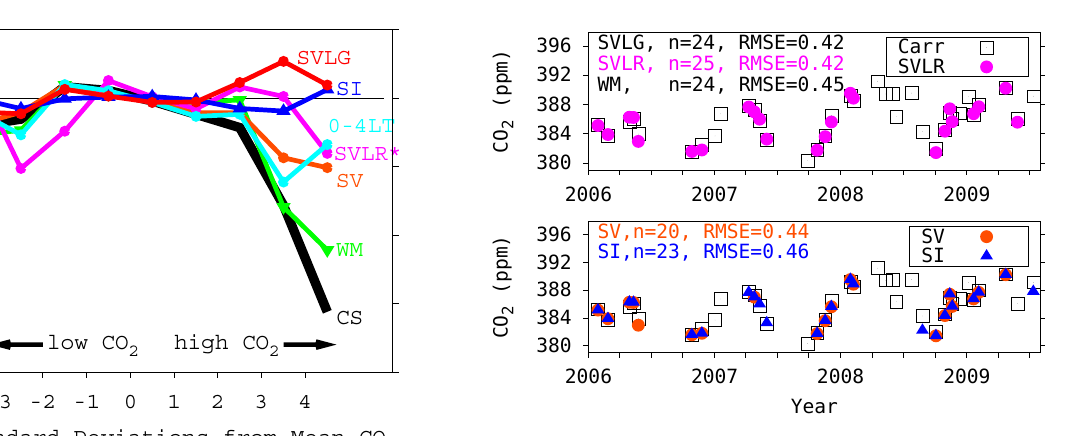
Fig. 4. CO 2 lapse rates binned by standard deviations from the deseasonalized subset mean. These show the average degree of CO 2 stratification in the vicinity of the measurement stations. On the vertical axis (CO 2 lapse rate) measurements representing well- mixed conditions appear near-zero, while measurements represent- ing strongly stable conditions have large negative values. On the horizontal axis (standard deviations) measurements typical of after- noon CO 2 uptake appear to the left, while nocturnal measurements (tending to have larger CO 2 values) appear to the right.